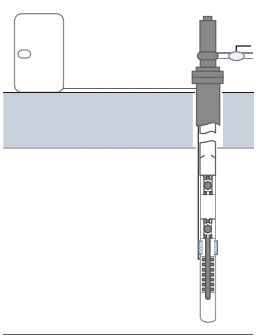
Figure 1: Experiment platform.